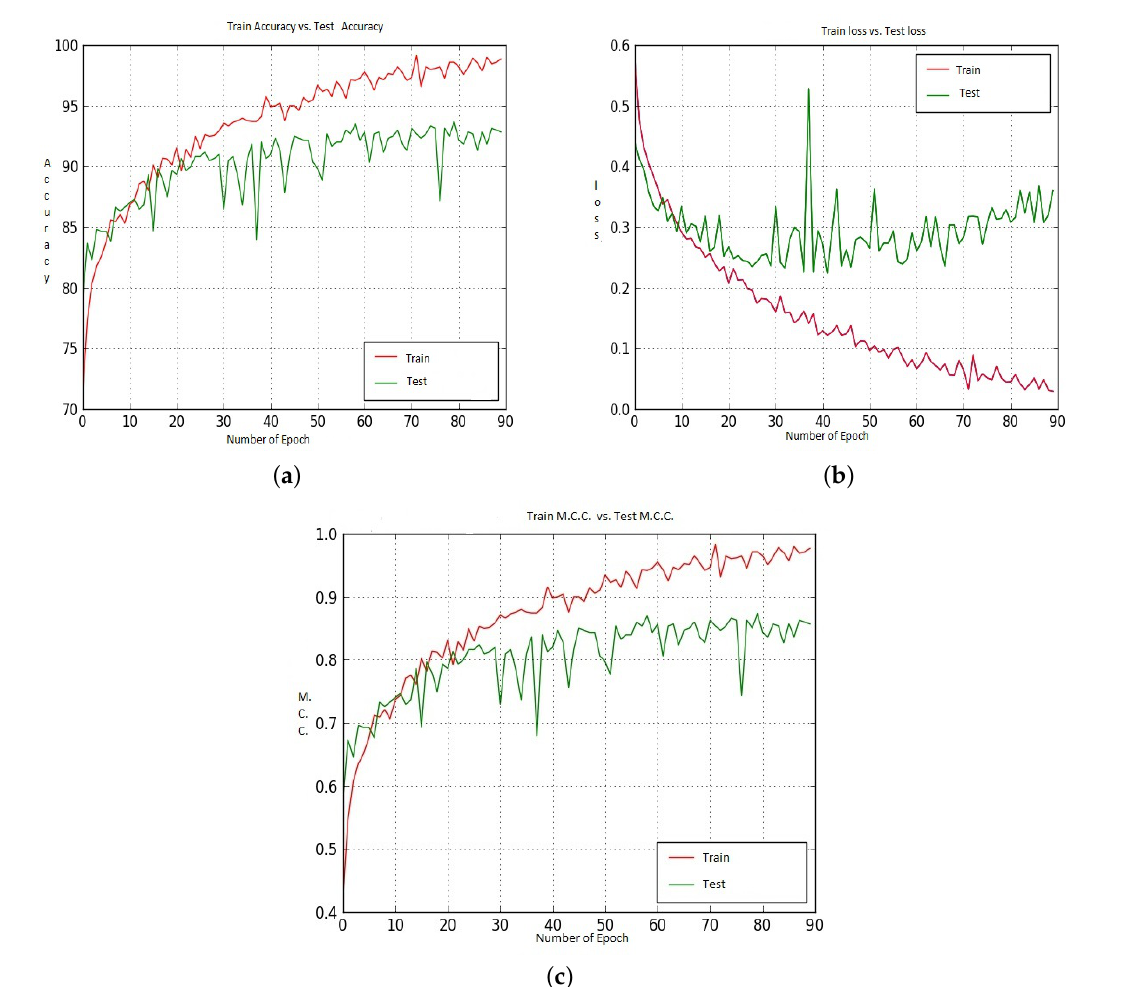
Figure 10. ( a – c ) represent the Train and Test Accuracy, Loss and M.C.C. values when we utilized Model-1, CNN-CH on the 40 ×